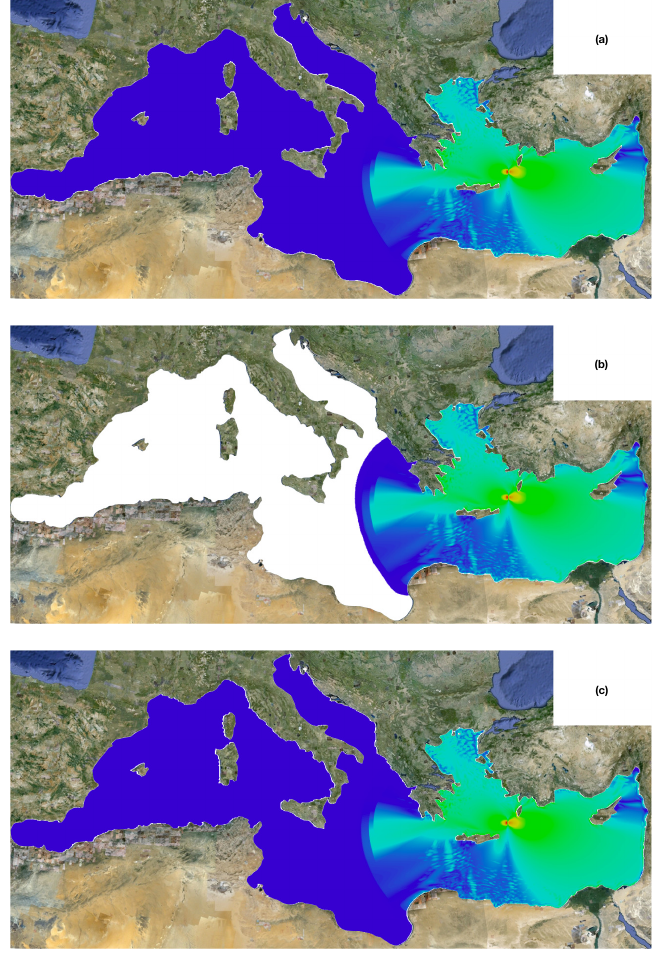
Figure 12. Comparison between the three method full ( a ), domain adaptation ( b ) and adaptive mesh generated by FreeFem++ with err = 10 − 7 ( c ) of the maximum of the propagation of the solution of a tsunami wave in the M EDITERRANEAN sea for t = 6800 s (min = 0 m, max = 0.4 m, for three